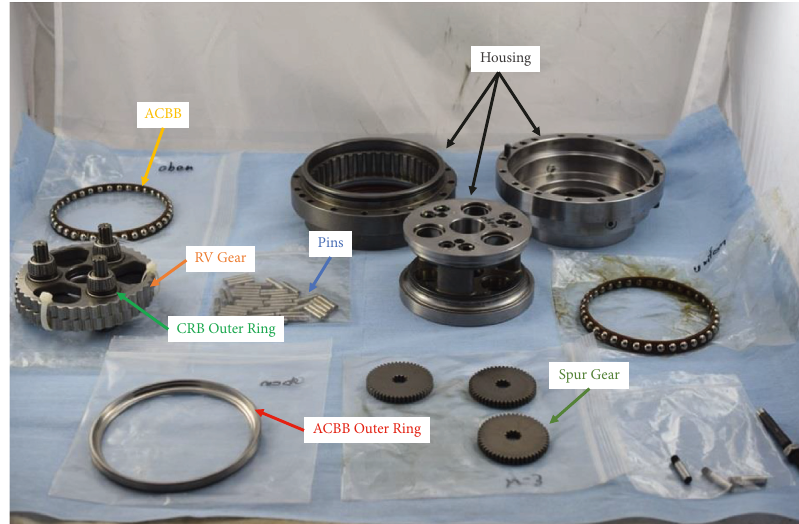
Figure 2: Dismantled nabtesco